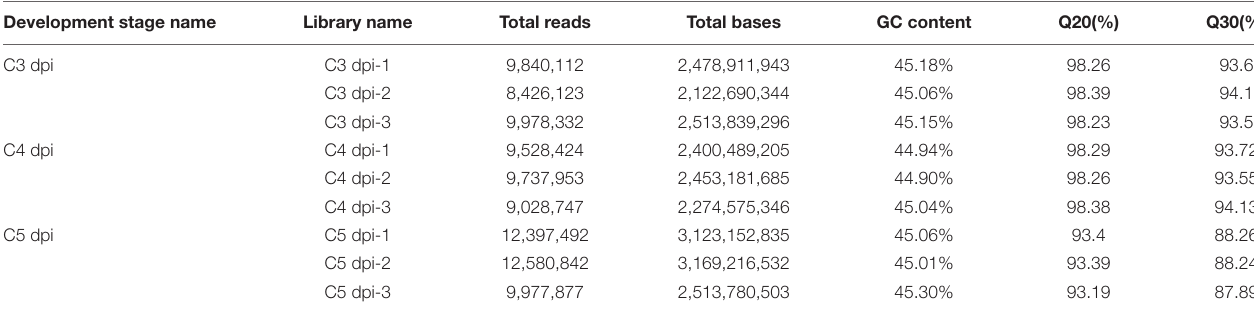
TABLE 1 | Descriptions of nine RNA-seq libraries of Bgt during development on Chancellor at 3, 4, and 5